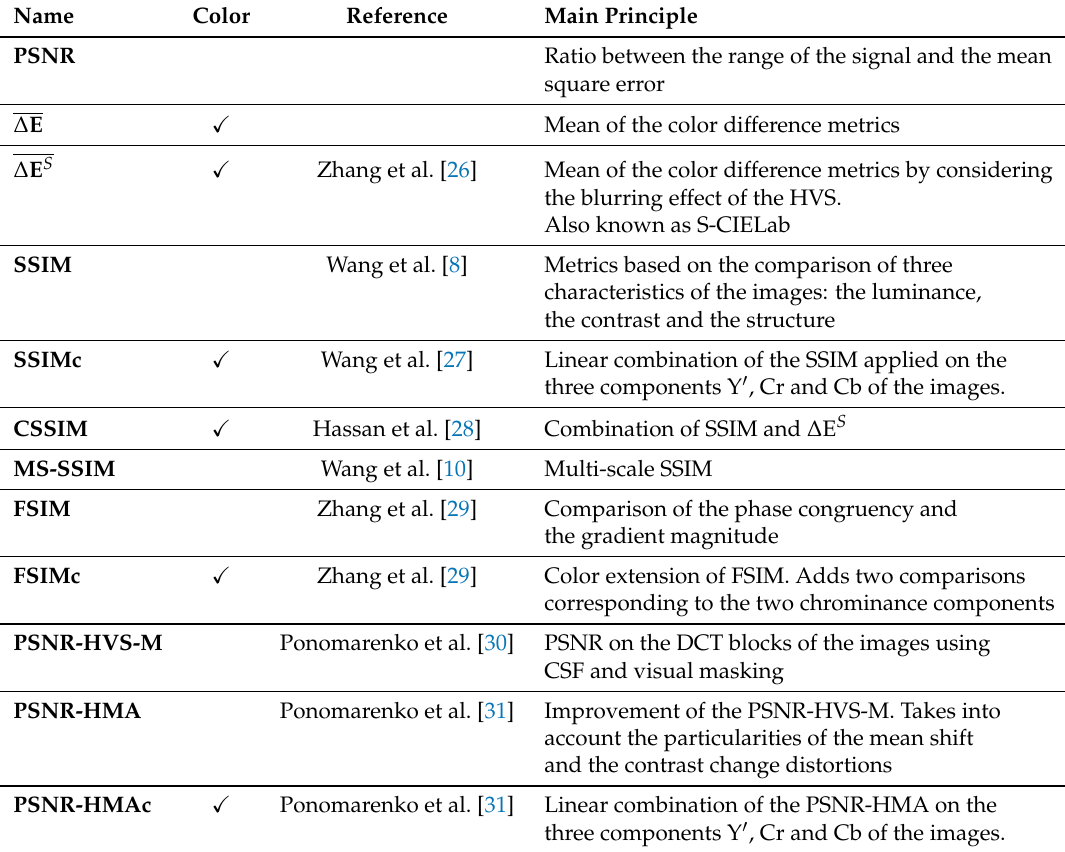
Table 1. Selected SDR quality